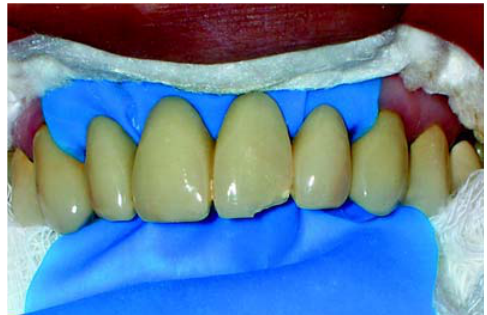
FIGURE 2- Isolation and protection of the patient’s mouth with rubber dam, cottons, gauzes and a lip expander.